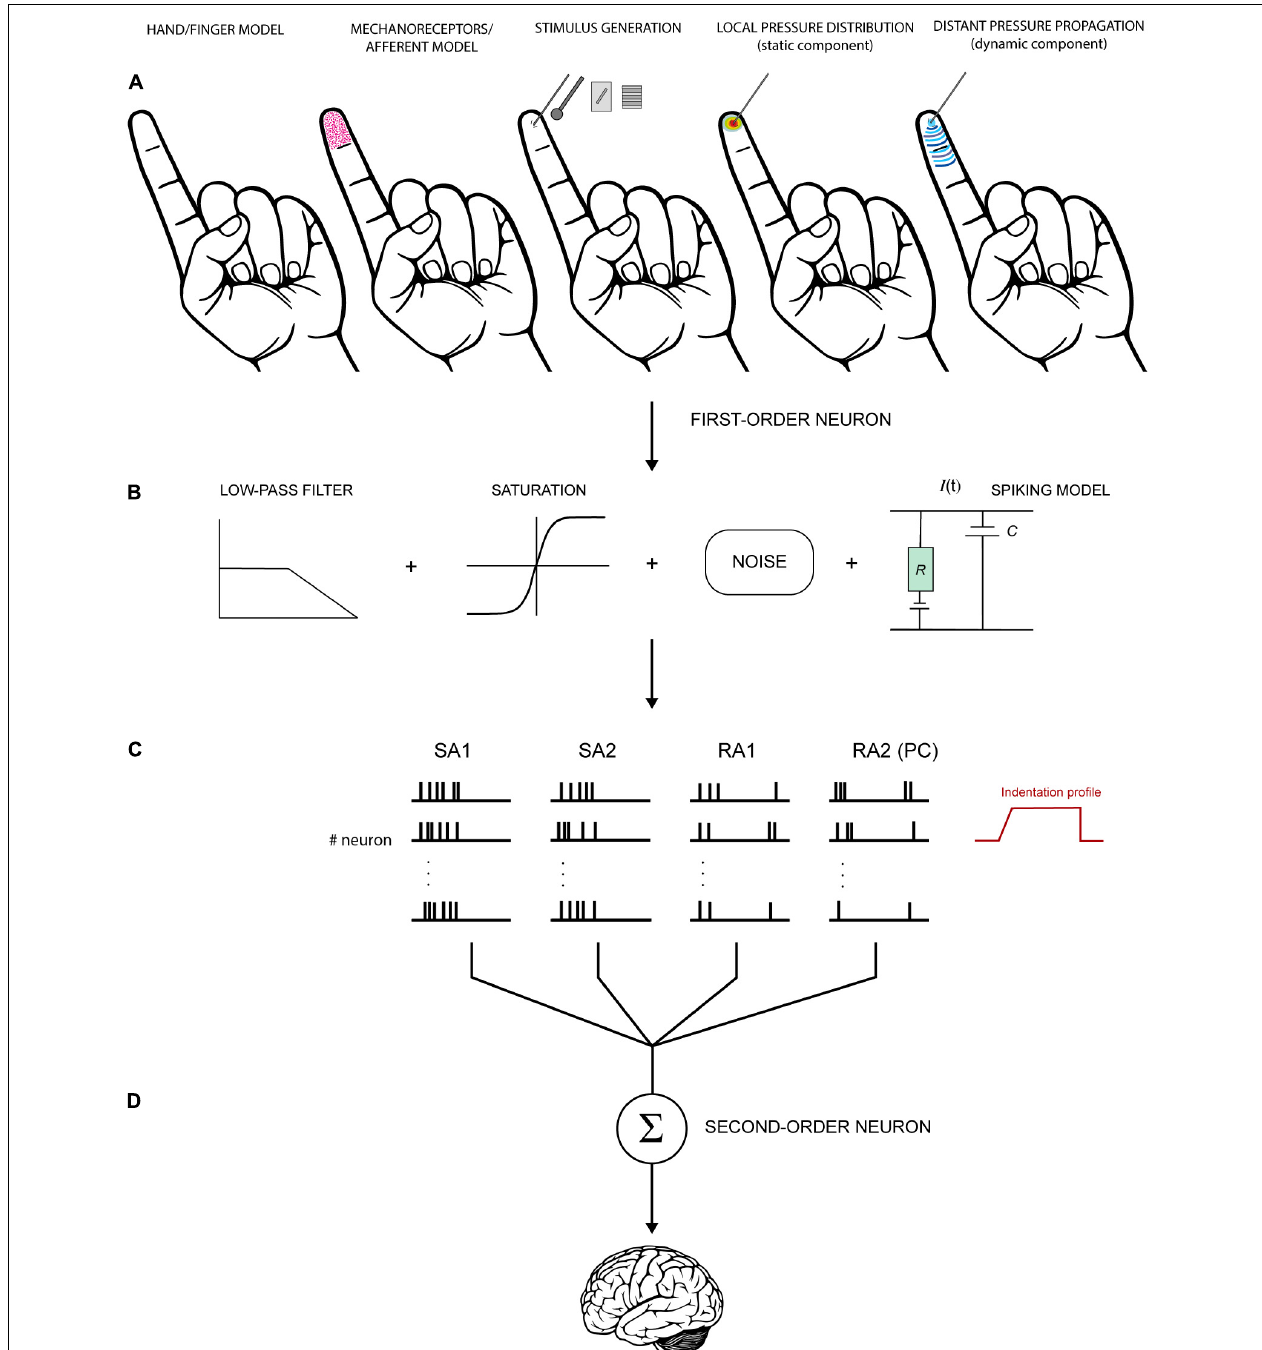
FIGURE 5 | Schematic view of a hypothetical model to simulate the activity of tactile units of the hand. (A) First step involves the definition of the hand/finger model (shape, geometry, and mechanics), the depth and density of receptors/fibres, and the stimulus generation. Then, these factors are used to compute local and distant pressure distribution and derive the stresses acting at the receptors’ depth. (B) The mechanical output is fed into a neural model to generate spiking responses. The signal can be transformed through a series of functions to resemble the biological properties of the neurons. For example, low-pass filter is often used to account for the fact the tactile units do not respond above certain frequencies. Saturation reproduces the tendency of the neurons to saturate at high intensities. Eventually, noise is introduced to account for the random occurrence of the spikes in some conditions. (C) Spikes are generated for each receptor or each tactile unit (receptors and fibers together, first-order neurons). The activity of each receptor must be integrated to account for innervation branching observed in SA1 and RA1 but not in RA2 (PC) and SA2. (D) Subsequently, the output of first-order neurons is combined at the level of second-order neurons for further processing before is transmitted upstream. The last step is often overlooked in this kind of models but is fundamental to understand the nature of the information that is sent to the brain.